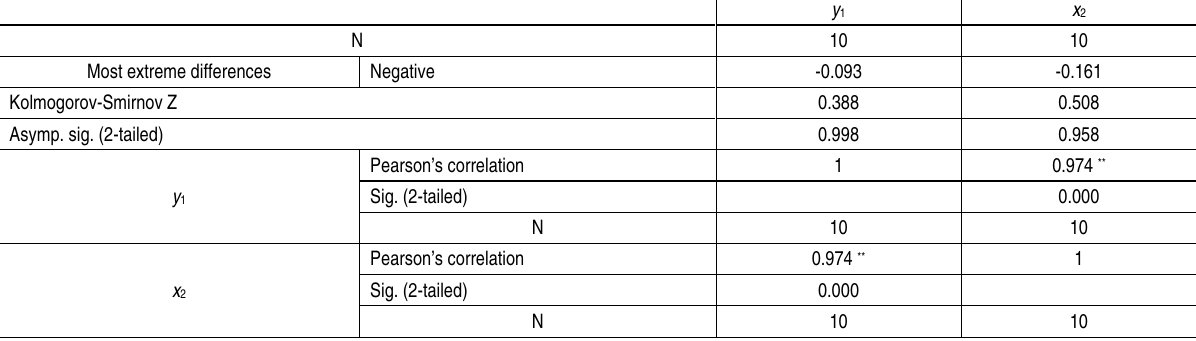
Table 14 (cont.). The second hypothesis test result (normality test and correlation analysis)